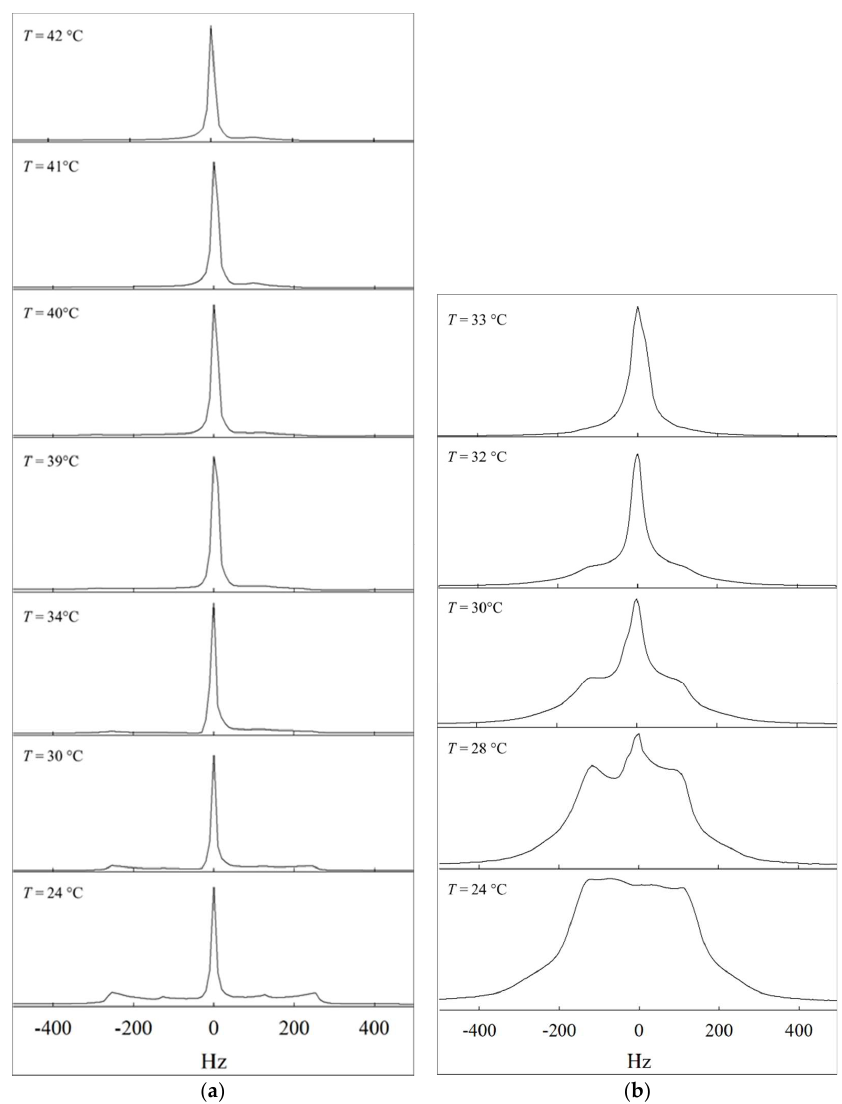
Figure A2. ( a ) Temperature dependent 2 H NMR spectra of the system D 2 O–C 12 E 7 recorded at γ a = 0.37. ( b ) Temperature dependent 2 H NMR spectra of the system D 2 O–C 12 E 7 –12-HOA recorded at γ a = 0.36 and at η = 0.015. The asymmetry seen in the spectra may have several reasons. One is the local anisotropy, which causes an anisotropy of the magnetic susceptibility and therefore an orientation dependent shift in addition to the orientation dependent quadrupolar splitting. Therefore, the isotropic peak is not exactly in the center of the two maxima (which correspond to domains aligned with the phase axis perpendicular to the magnetic field), and the maxima are not exactly in the middle of the two outer shoulders (which correspond to domains aligned with the phase axis parallel to the magnetic field). Additional asymmetries arise from shim and phase errors.